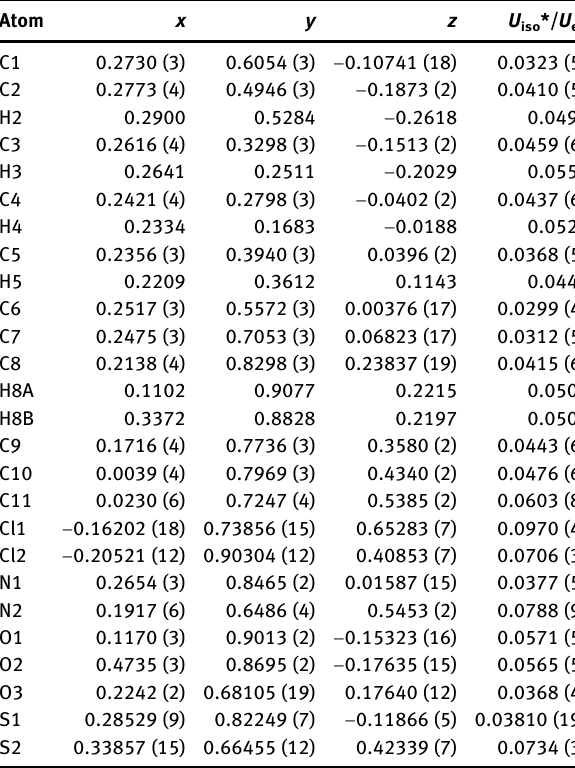
Table  : Fractional atomic coordinates and isotropic or equivalent isotropic displacement parameters (Å 